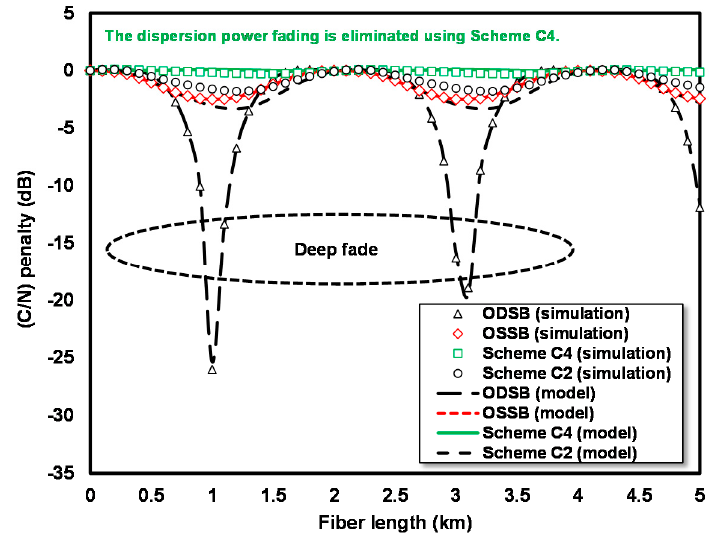
Figure 14. C / N penalty for the RoF link with ODSB and OSSB modulations, scheme C4 irregular θ and scheme C2 irregular θ at m = 1.